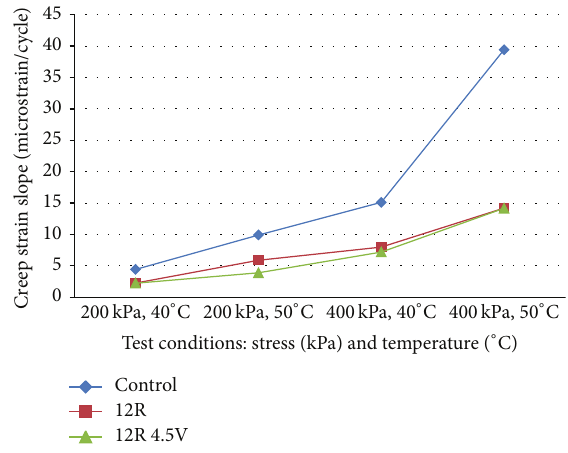
Figure5:CSSresultsforcontrolandrubberizedmixturesversustest